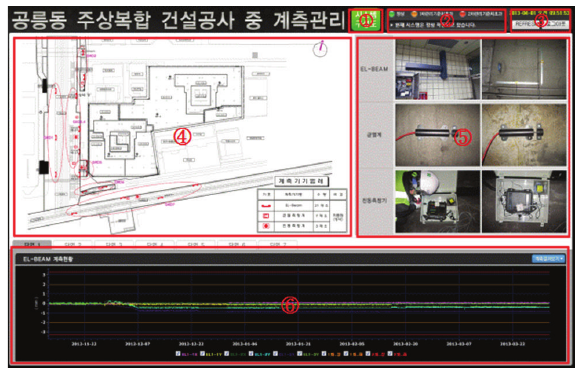
Figure 5: The example of CSD. Table 3: The project summary.